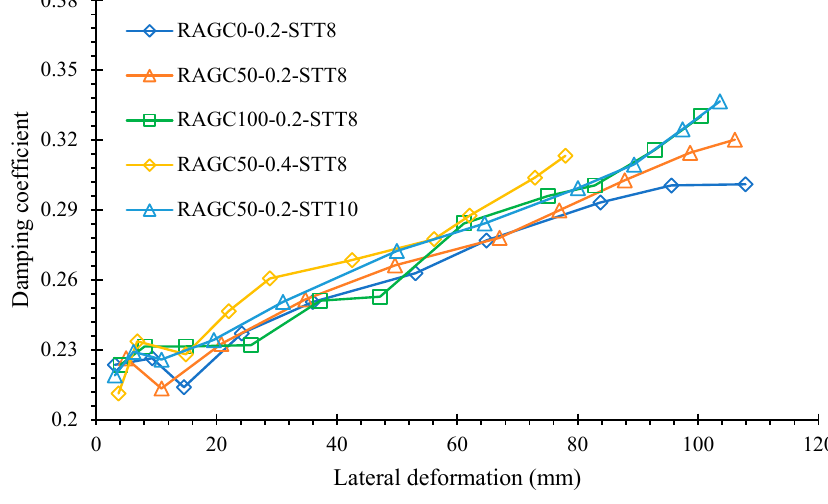
Figure 13. Viscous damping coefficients of specimens.